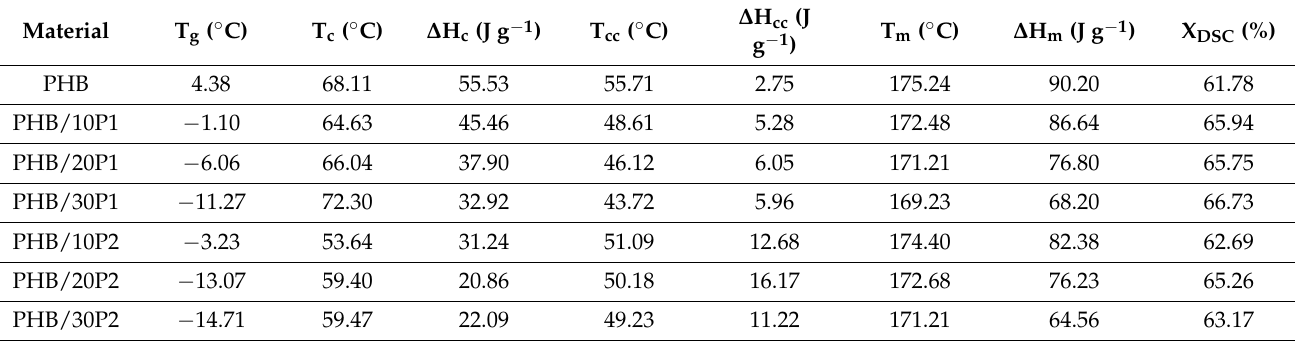
Figure 5. DSC thermograms corresponding to reheating ( a , c ) and cooling runs ( b , d ) of PHB, PHB/P1, and PHB/P2. Table 3. Main parameters obtained from DSC analysis of PHB, PHB/P1, and PHB/P2. T g is the glass transition temperature; T c is the crystallization peak temperature; ∆ H c is the enthalpy of crystallization; T cc is the cold crystallization peak temperature; ∆ H cc is the enthalpy of cold crystallization; T m is the melting peak temperature; ∆ H m is the enthalpy of melting; X DSC is the calculated crystallinity.